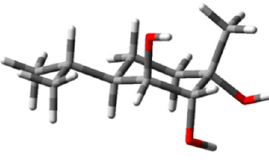
Figure 3. The most stable conformer (DFT/B3LYP/6-31G(d)/IEFPCM(CH 3 CN)) of (1 S ,2 R ,3 S ,4 R )- 1 . The structure atoms are coloured as follow: carbon (grey), hydrogen (light grey), oxygen (red). UV and ECD spectra for (1 S ,2 R ,3 S ,4 R )- 1 were calculated on previously found